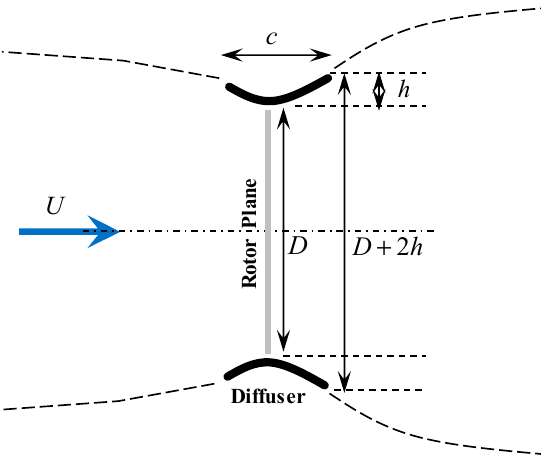
Figure 1. Dimensions of the diffuser cross-section .